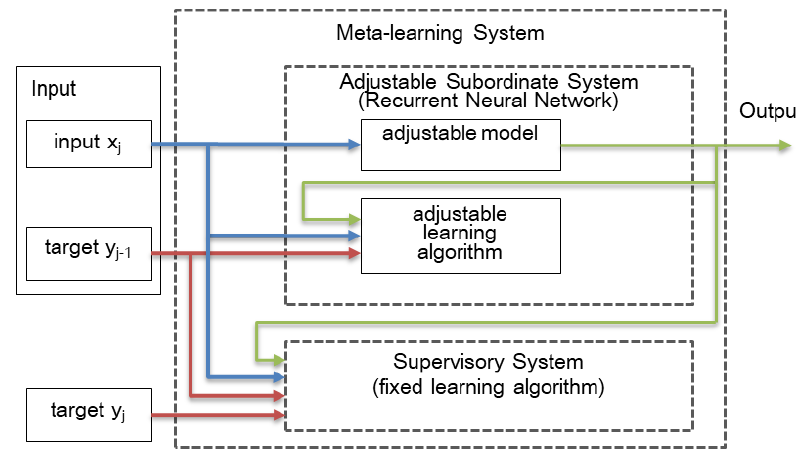
Figure 1. Overview of the Meta-learning system using Recurrent Neural Network. The subordinate system plays a role as a self-adjustable